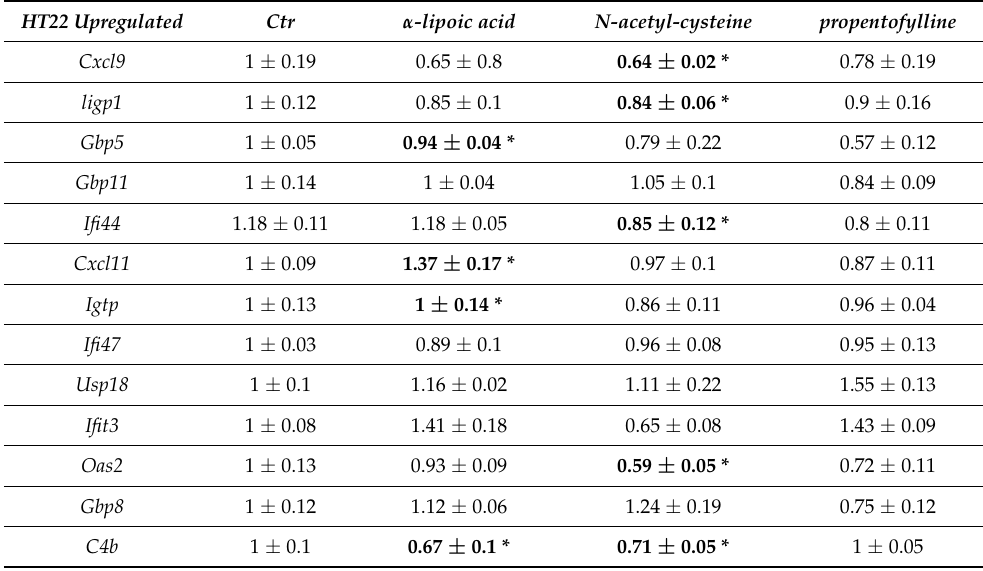
Table 1. Fold change ± SEM of inflammatory marker genes in HT22 compared with non-inflamed cells. The statistically significant differences between treated and untreated control cells are shown by asterisks (* p < 0.05, ** p < 0.01) and bold type. HT22 Upregulated Ctr α -lipoic acid N-acetyl-cysteine propentofylline Ifi44 Cxcl11 1 ±